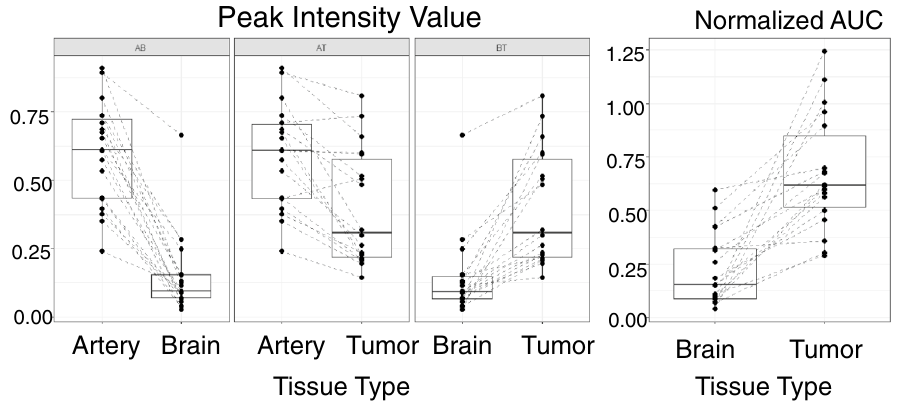
Figure 4. Boxplot for Peak Intensity and for Normalized AUC of brain and tumor with paired observations (for each patient) connected by dashed lines. AB: Artery v. Brain; AT: Artery v. Tumor, BT: Brain v. Tumor.